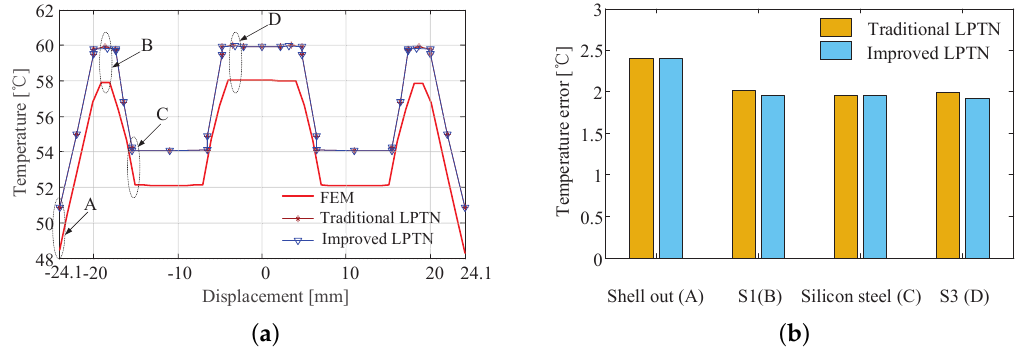
Figure 13. ( a ) Temperature distribution in x direction at 15 A. ( b ) Temperature error at several